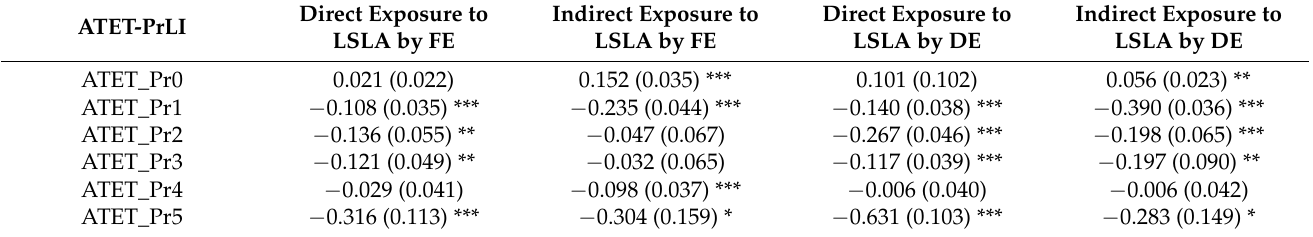
Table 7. Average effect of exposure to LSLA on level of investment in land improving techniques (ATET). Direct Exposure to ATET-PrLI